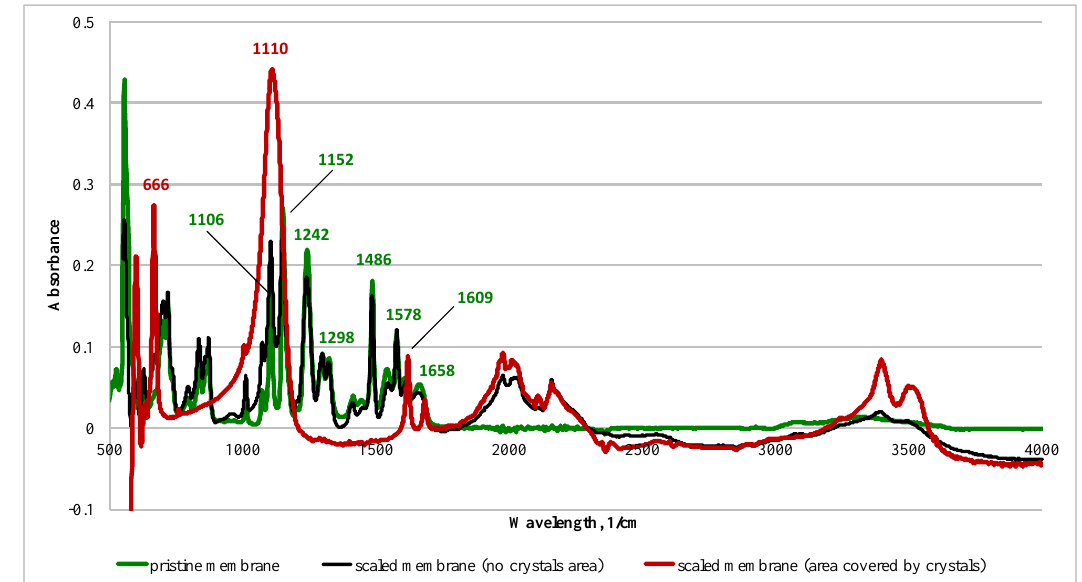
Figure 11. ATR-FTIR spectra of the membranes. Scaling conditions: concentrations of NaCl, CaCl 2 , and Na 2 SO 4 are 1.754, 6.132, and 4.487 g/L, respectively; SI = 2.45; 12.5 cm/s cross-flow velocity; the feed and draw solutions were circulated counter-currently; and an AL-FS orientation.